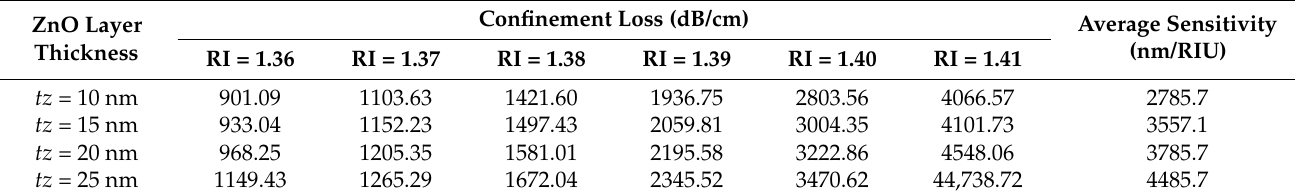
Table 2. Maximum confinement loss of the sensor for different thickness of zinc oxide and analyte RIs and corresponding average sensitivity. Confinement Loss (dB/cm) Average ZnO Layer Thickness